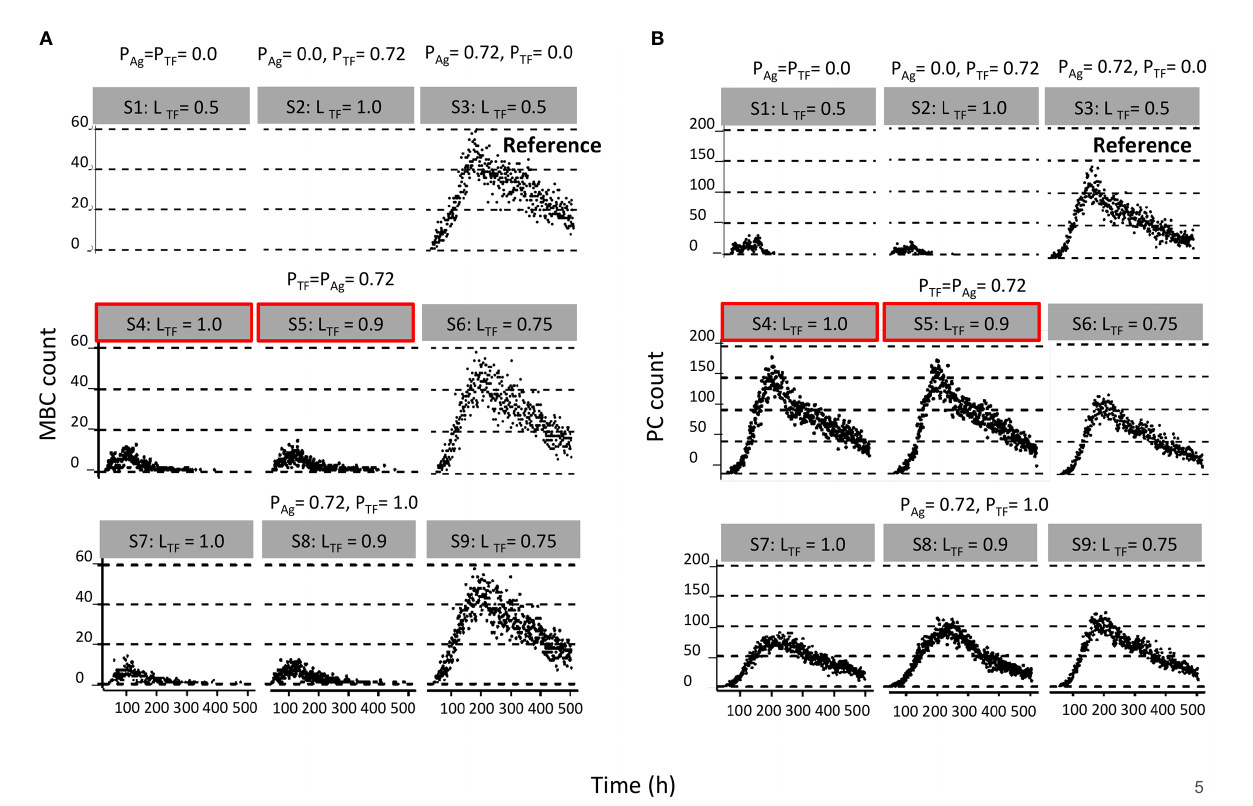
FIGURE 4 | Results from fi rst set of simulations ( Table 2 ). (A) Relative MBC and (B) PC count during the GC. The probability of asymmetric division (P) is indicated above the gray box and simulation number and polarity levels (L) are shown in the gray box. First row of plots corresponds to (left column) symmetric division of Ag and TFs, (middle column) symmetric division of Ag and asymmetric division of TFs, and (right column) symmetric division of TFs and asymmetric division of Ag. Second row of plots corresponds to asymmetric TF division only if mode of Ag division is asymmetric. Red boxes indicate parameters that are closer to biological results. Third row of plots corresponds to always asymmetric TF division regardless of mode of Ag